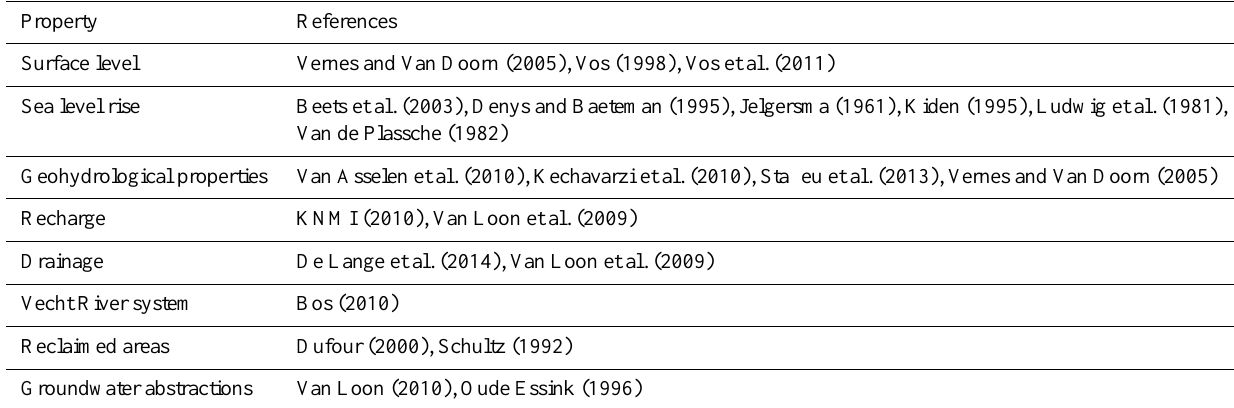
Table 3. References for paleo-model implementation.